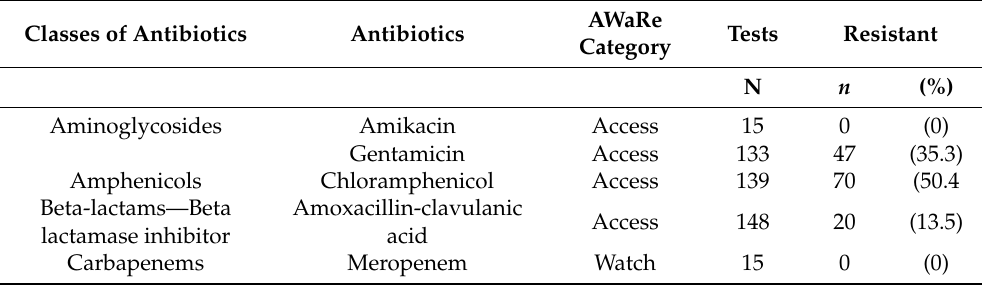
Table 6. Resistance of isolates to antibiotics, stratified by AWaRe category, among neonates